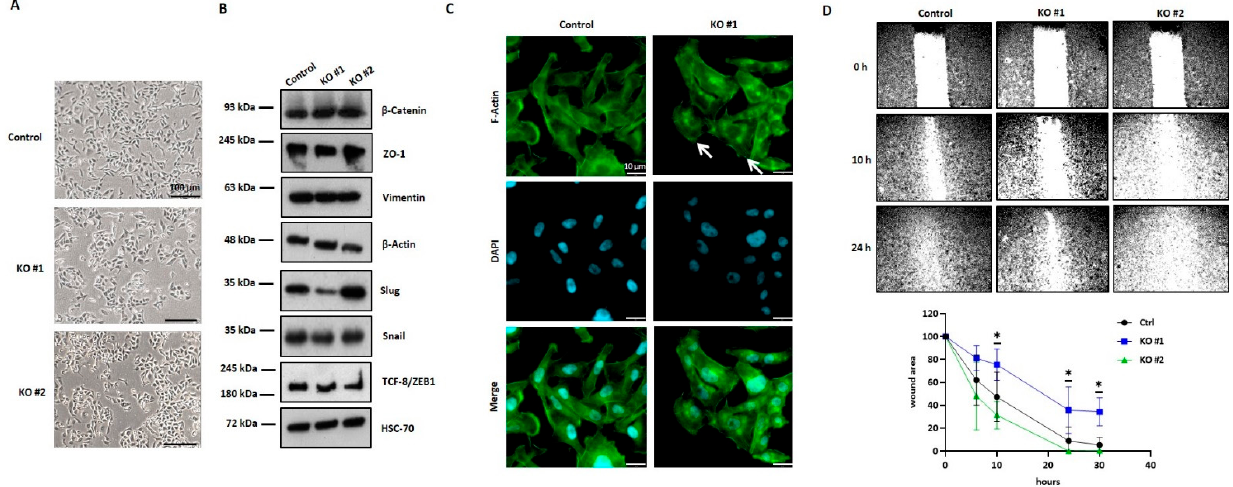
Figure 4. Phenotypic changes in HYLA1 KO cells and their influence on mesenchymal–epithelial transition (MET) and migration. ( A ) Representative pictures of HYAL1 KO MDA-MB-231-BR cells and the corresponding control. Scale bars represent 100 µm. ( B ) Representative Western blot analysis ( n = 2) of protein lysates (20 µg) of MDA-MB-231-BR control, HYAL1 KO #1, and HYAL1 KO #2 showing expression of different MET markers. HSC-70 (70 kDa) and β -Actin (45 kDa) were used as loading controls. ( C ) Immunofluorescence staining of F-actin (Alexa-fluor568 conjugated phalloidin). Scale bars represent 10 µm. (D, upper panel) Representative pictures showing migration ability of MDA-MB-231-BR control, HYAL1 KO #1, and HYAL1 KO #2 cells at the time of wound scratching (0 h), 10 h, and 24 h post-scratching. Magnification 5× (D, lower panel). Graphical representation of the wound closure in % of the existing wounding area ( n = 3). Statistical significance was determined using unpaired two-tailed Student´s t-tests. The assumption of homogeneity of variance was tested using Levene´s Test of Equality of Variances ( p > 0.05). Values are means +/ − s.d. * p < 0.05.